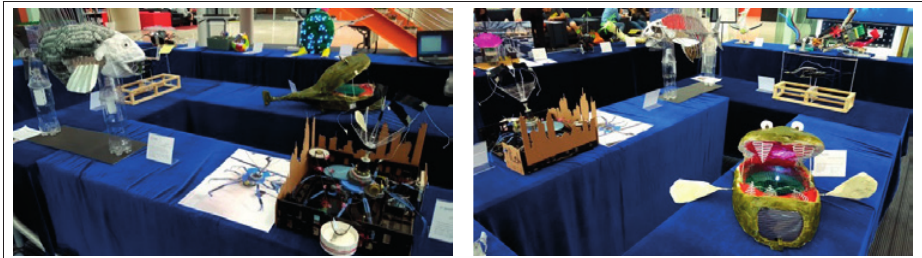
Table 3. Descriptions of fi ve group projects (source: created by author) Selected environmental Group issue Living in acidic soils, A Soil acidifi cation has its digestive organ pro- been accelerated by the duces alkaline fl uids. It use of chemical fertilizers reduces levels of toxic- that reduce the amount ity by eating acidifi ed of nutrients recycled by soils and excreting micro-organisms. neutralised soils. Th is fl ying creature B Fine dust pollution has ad- reduces the verse eff ects on humans and concentration of fi ne on the ecosystem. In recent dust in the air in years, this has become a industrial areas such serious problem, with in- as Tianjin in Hebei, creased industrial pollutants China. contained in the dust. C Th e rapid infl ow of Living in the sea, it microplastics causes reduces microplastic harmful physical and pollution. Th e bacteria chemical eff ects in the living in its stomach marine environment. break down the drift ing microplastics. D Algae causes water Living in rivers, it pollution by creating gathers the green oxygen-poor “dead-zones” algae, which it uses to in the water. make biofuel.